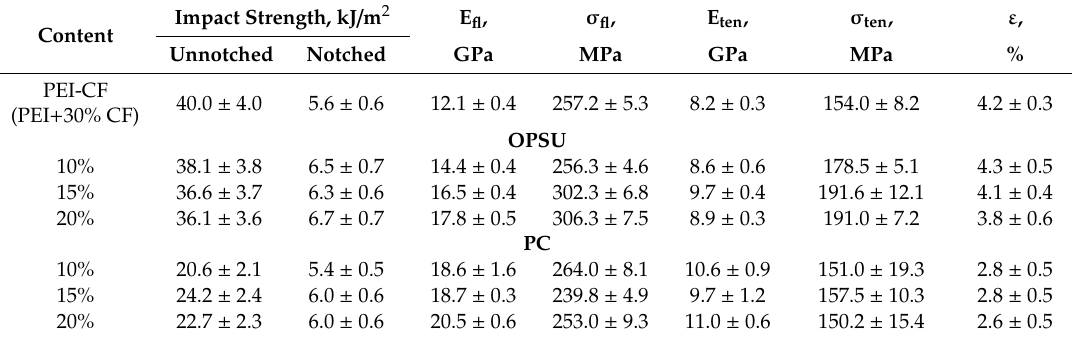
Table 4. Mechanical properties of carbon-filled PEI with di ff erent content of OPSU and PC. Content